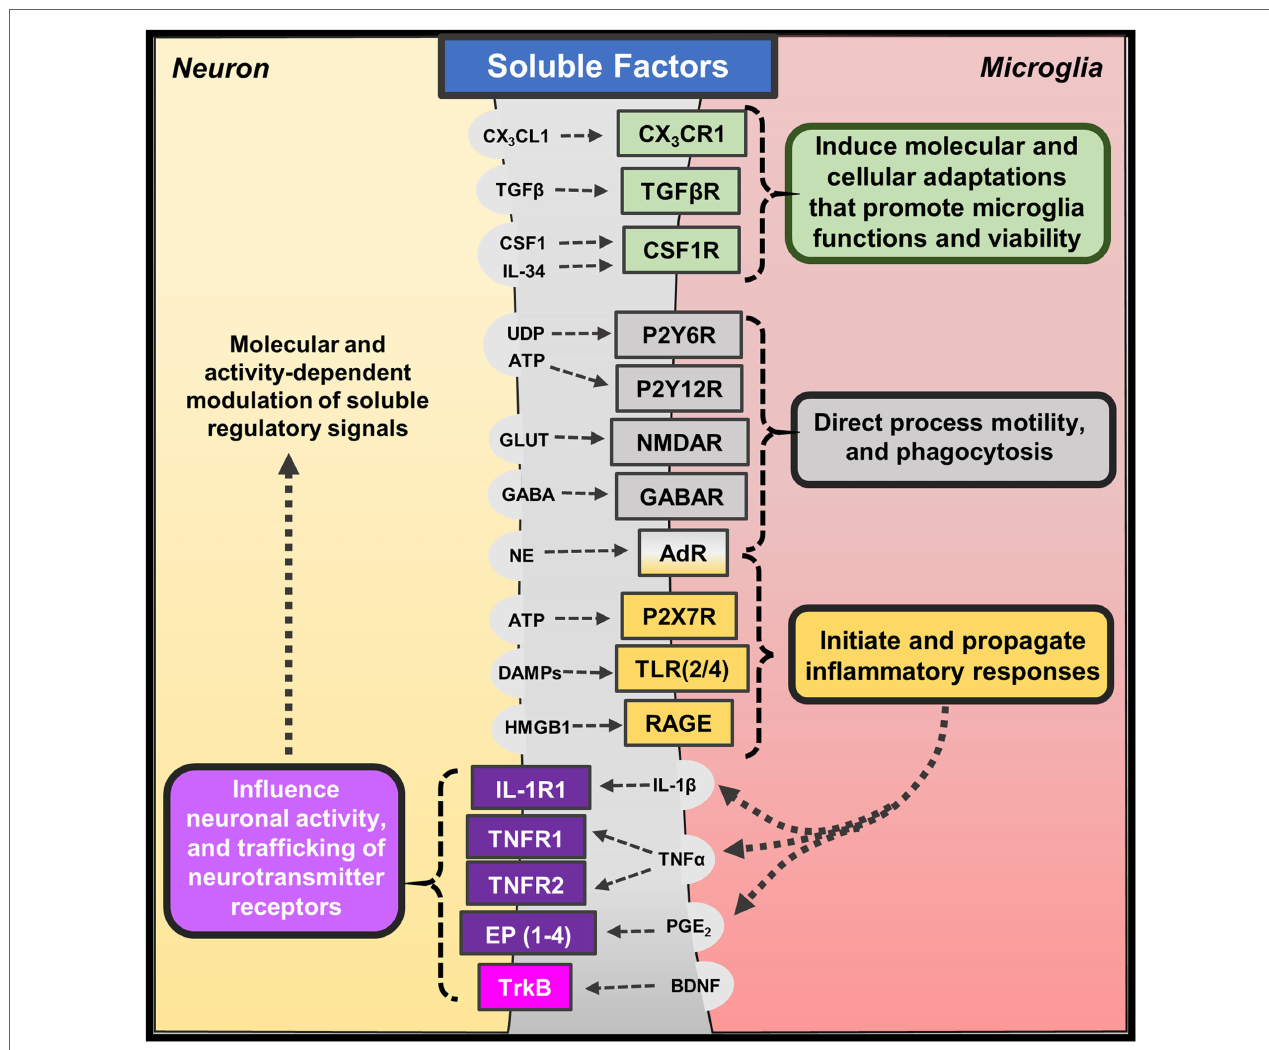
FiGURe 1 | Soluble factors regulating neuron–microglia interactions . Several molecular and cellular pathways mediate neuron–microglia interactions. Neurons release soluble immune-related factors (fractalkine – CX 3 CL1; transforming growth factor- β – TGF β ; colony-stimulating factor-1 – CSF1; interleukin-34 – IL-34), nucleotides (uridine diphosphate – UDP; adenosine triphosphate – ATP), neurotransmitters (glutamate – GLUT; γ -aminobutyric acid – GABA; norepinephrine – NE), and danger- or damage-associated molecules (DAMPs; high mobility group box 1 – HMGB1) that bind to cognate receptors on microglia. These soluble neuron-derived signals promote many homeostatic functions but can also initiate or propagate neuroinflammation depending on the context. Microglia also release soluble factors, such as cytokines (interleukin-1 β – IL-1 β ; tumor necrosis factor- α – TNF α ), prostaglandins (prostaglandin E 2 – PGE 2 ), and neurotrophins (brain- derived neurotrophic factor – BDNF), which bind to neuronal receptors. Microglia often release these factors in response to fluctuations in neuron-derived signals; yet, low levels of microglia-derived cytokines are shown to promote homeostatic neuroplasticity through trafficking of neurotransmitter